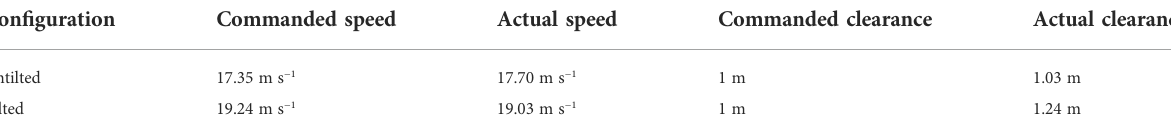
TABLE 4 The actual fl ight speed and clearance and the commanded fl ight speed and clearance.